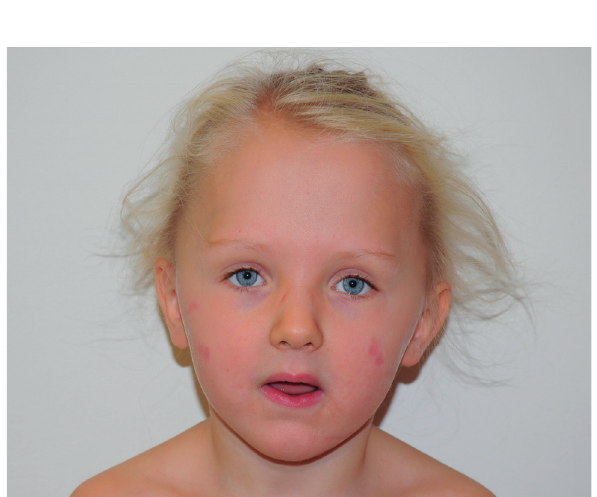
Fig. 1. Facial features of patient NM (with deletion of 19p13.2).